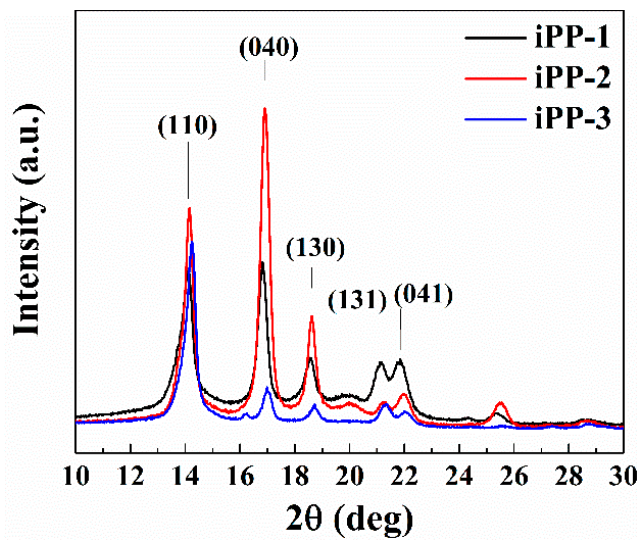
Figure 1. X-ray powder diffraction profiles of as-prepared specimens of the iPP samples.